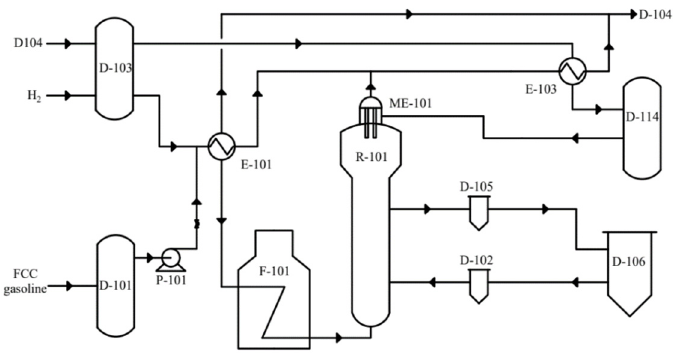
Fig. 1. S Zorb desulfurization reaction